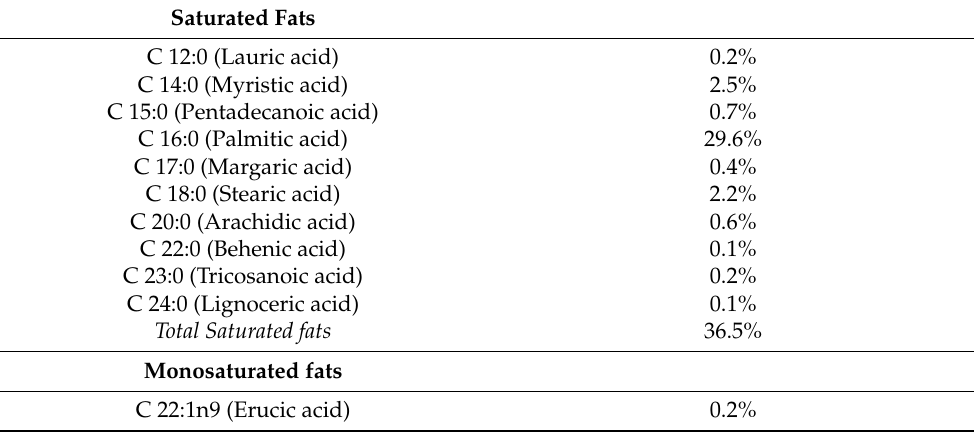
Figure A1. Theoretically expected fatty acid profile of feed formulated with either fish oil (negative control: ( A – C ); positive control: ( D – F )) or microalgal oil (3.5%: ( G – I ); 0.7%: ( J – L )) predicts the fatty acid profile actually observed in feed. Each vertical line represents a single feed sample. Each blue dot within each plot represents a different fatty acid. Table A1. Fatty acid composition of the microalgal oil used for the experimental trials